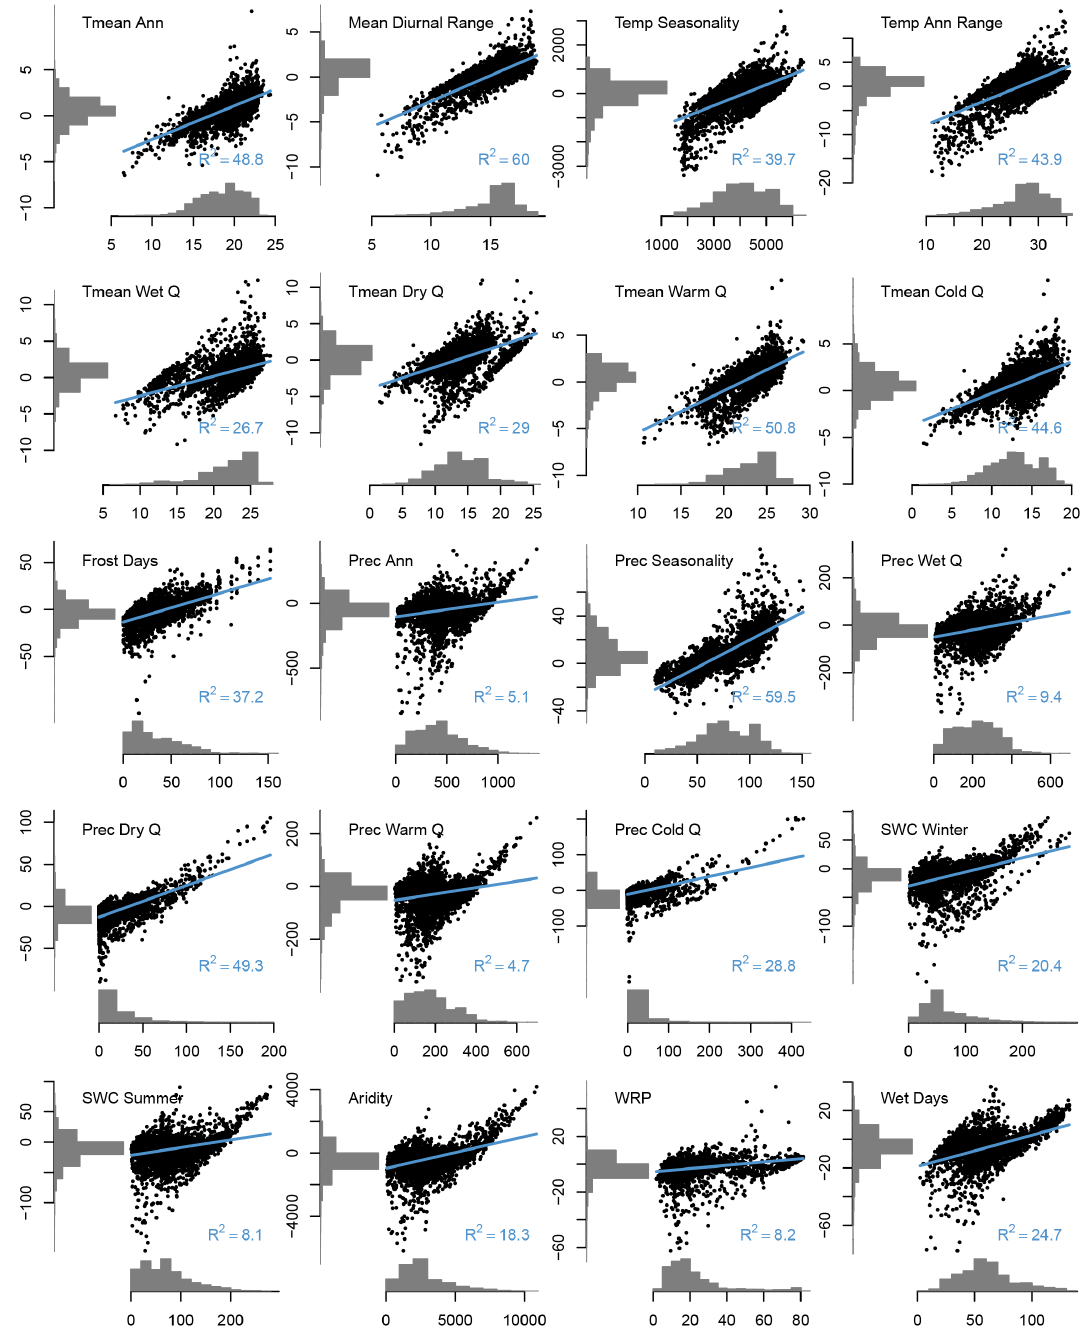
Figure 10. Anomalies plotted against their expected values. The density of points is heterogeneous: being very dense around the median climate and sparser at the extremes. This is illustrated by the histograms that represent the marginal distributions. The anomalies are smaller for the best-represented climate values and increase with distance from the median climate. The blue line represents the linear model fitted, with its associated R 2